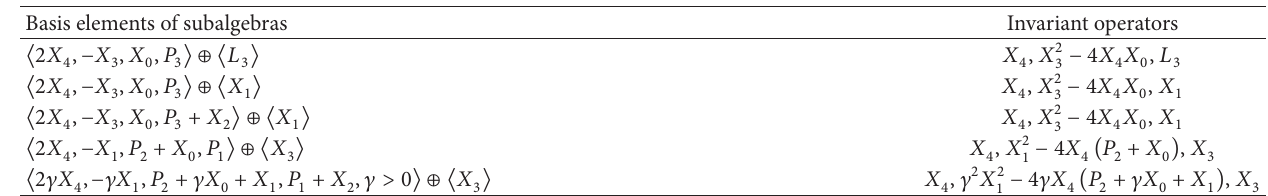
Table 10: Invariant operators of subalgebras of the type 𝐴 4,1 ⊕ 𝐴 1 .